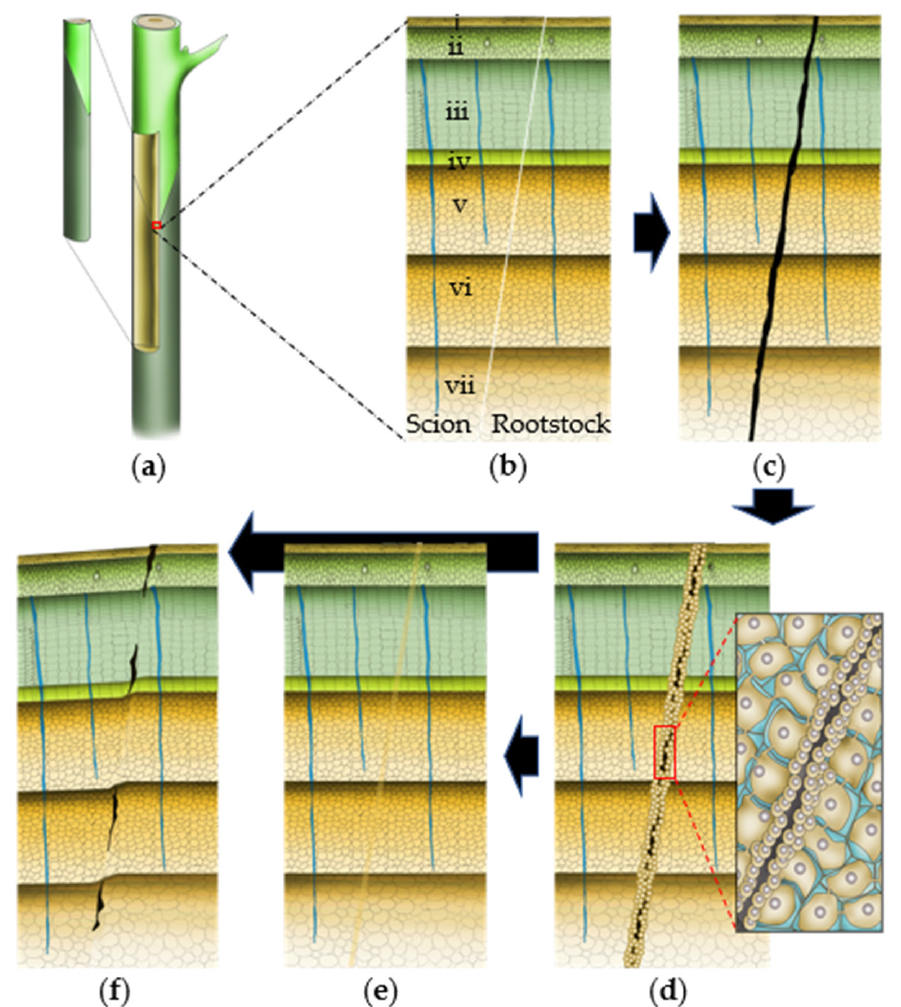
Figure 3. Basic anatomical states of graft establishment. ( a – f ) Typical transverse sections at the progressively healing graft union: ( a ) mechanically attached scion-rootstock combination with virtual sectioning at the graft joint; ( b – f ) magnified structure of a typical transverse section at the progressively healing graft union; ( b ) freshly attached scion and rootstock; ( c ) pectinaceous materials are secreted at the graft union and the attached graft partner surfaces are mechanically attached; the secreted pectinaceous materials, along with the cell debris forms a necrotic layer at the graft interface; ( d ) wound signal perception leads to the callus production at the graft interface, which thins out the necrotic barrier leading to the establishment of a callus bridge between two graft partners. The magnified image shows the proliferating callus cells before callus bridge formation at the graft interface; ( e ) a seamless connection is established at a compatible graft union; and ( f ) partially compatible graft unions often exhibit the remnants of the necrotic layer and/or aberrant vascular continuity. In severe incompatibility cases, the necrotic layer never disintegrates at all. i = cork and epidermis ii = cortex; iii = phloem; iv = vascular cambium; v = xylem; vi = protoxylem; vii = pith.